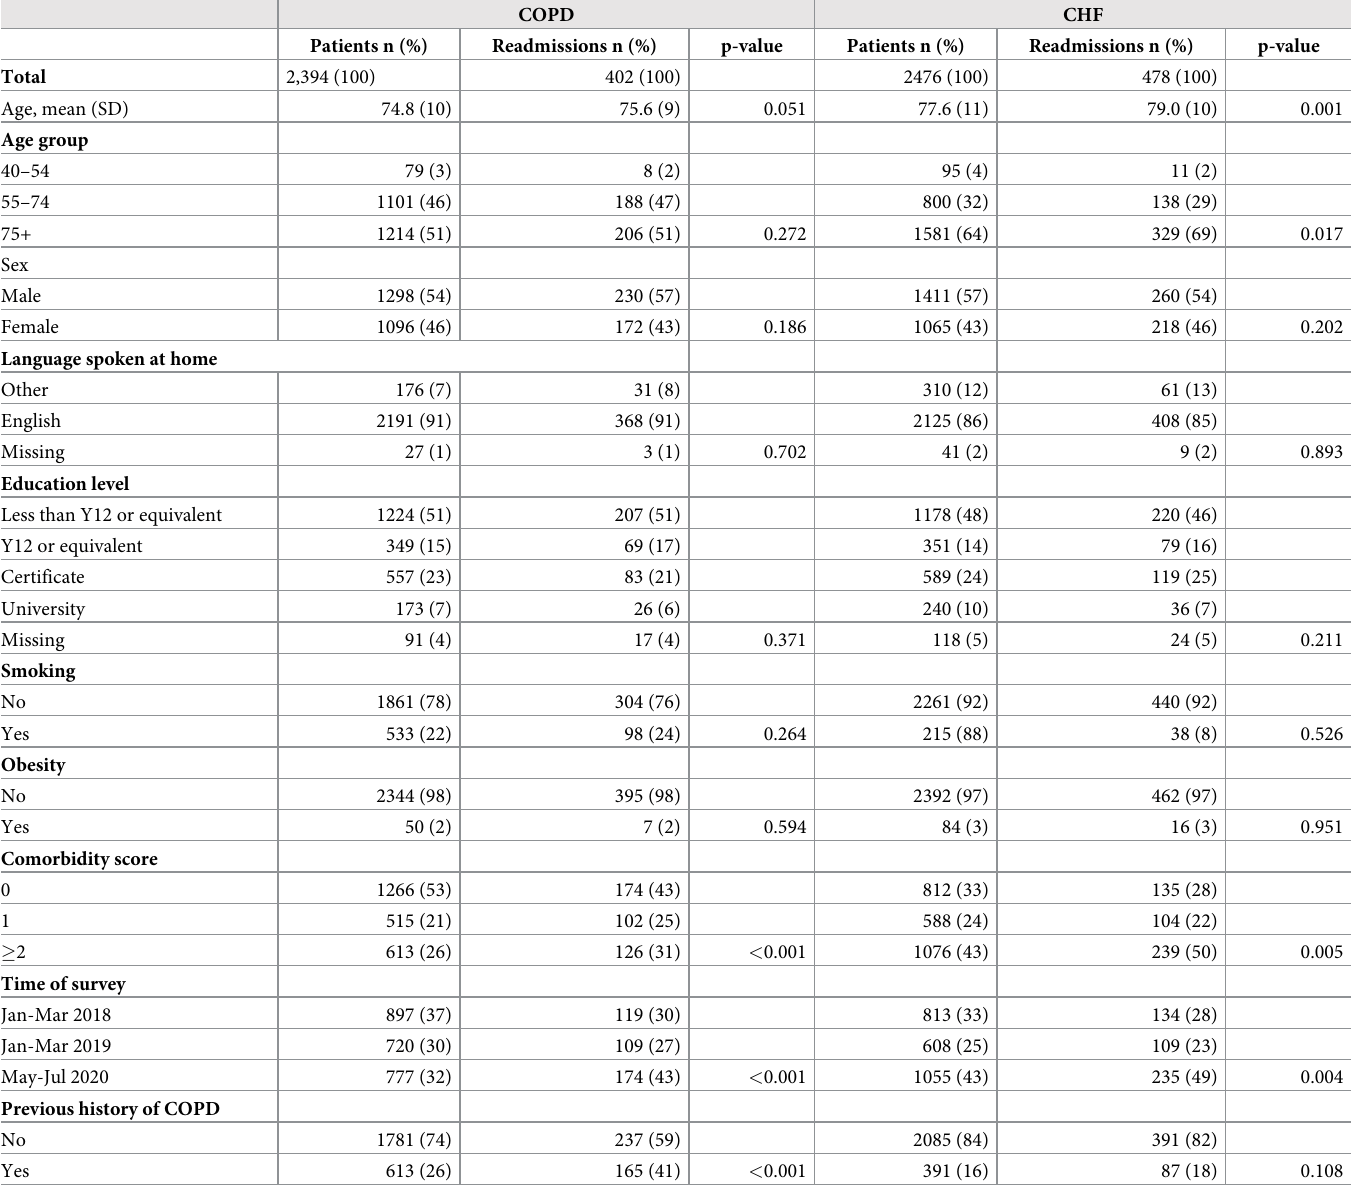
Table 2. Social, demographic, and clinical characteristics for participants who have COPD or CHF,